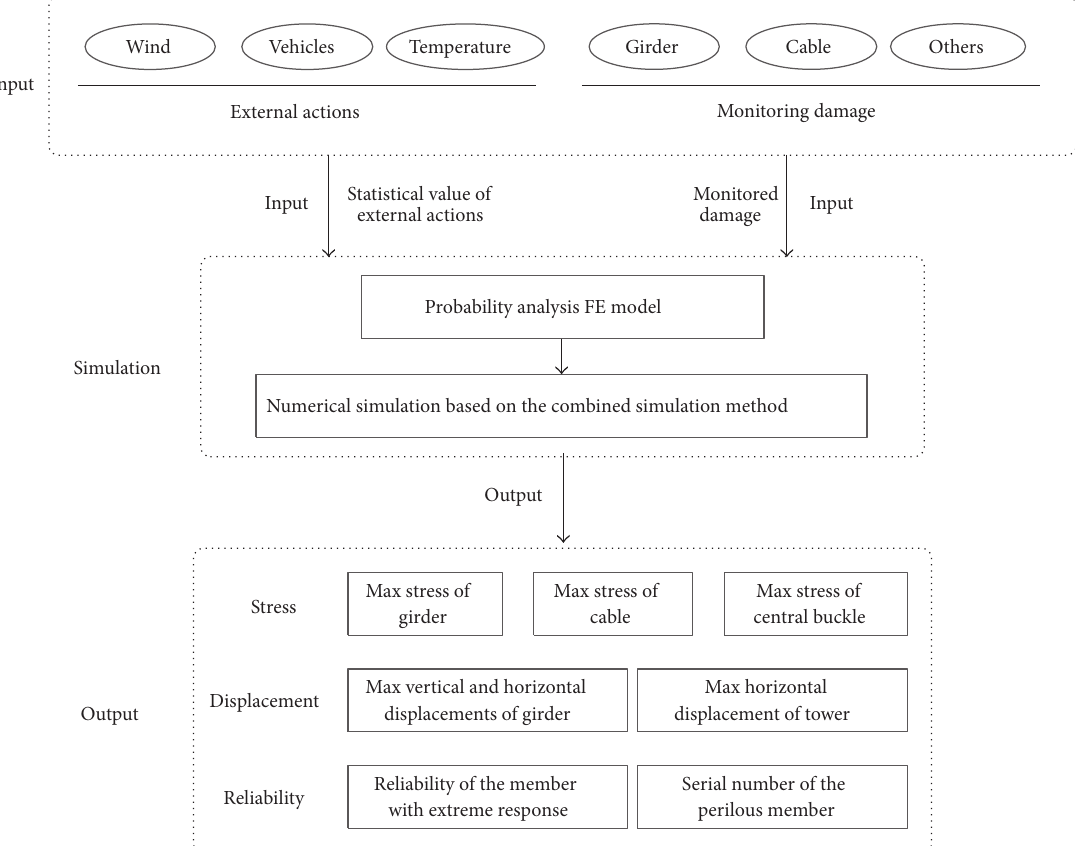
Figure 18: Reliability assessment of